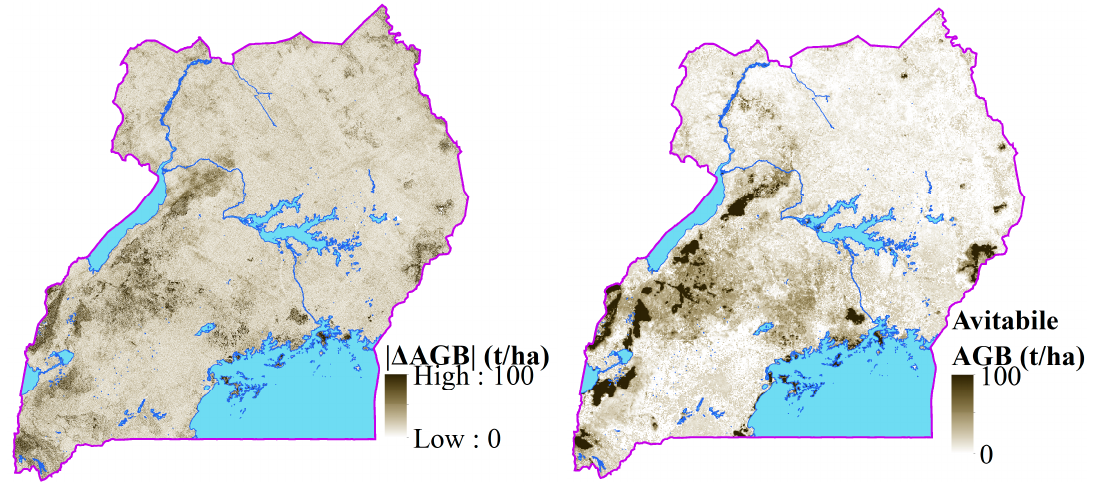
Figure 7. Maps of the absolute value of Δ AGB (left) and AGB based on [15].